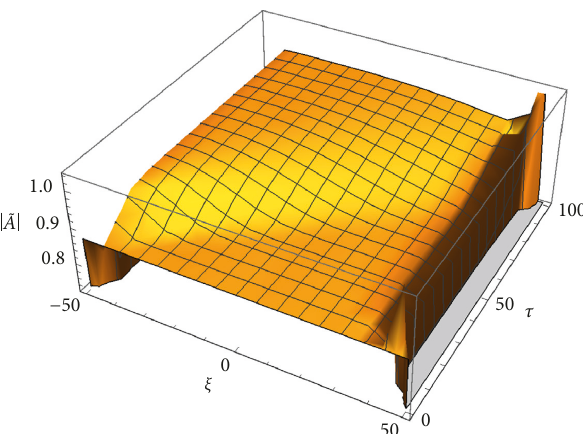
Figure 6: Plot of the | 􏽥 A | for the case c initial condition is of the form f ( ξ ) �